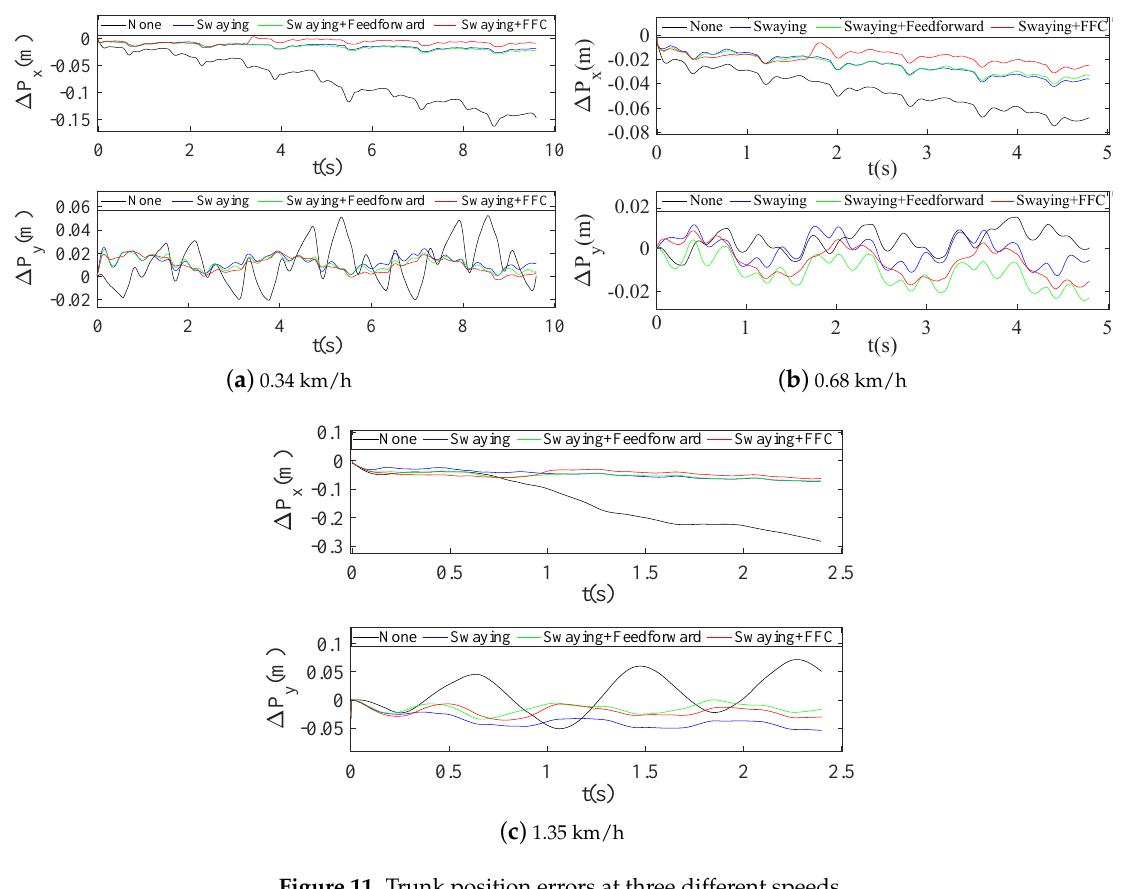
Figure 11. Trunk position errors at three different